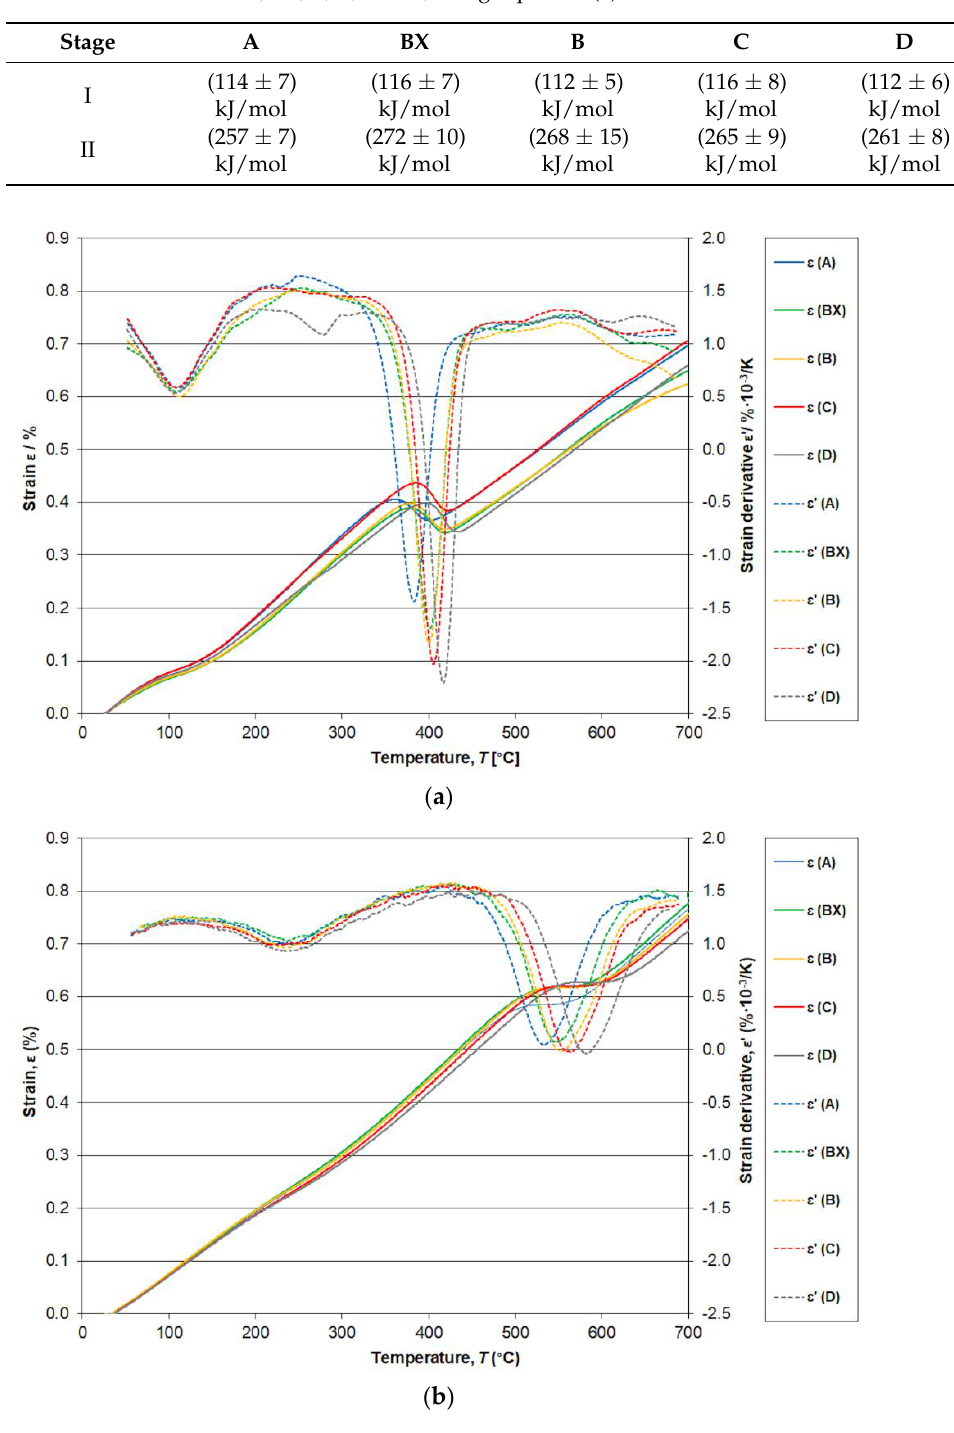
Table 3. Temperatures corresponding to inflection points ( T i ) at different heating rates ( β ) for stage II of tempering in the dilatometry data.